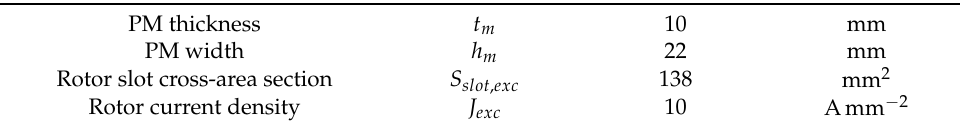
Table 3. PRC-6 rotor geometry.